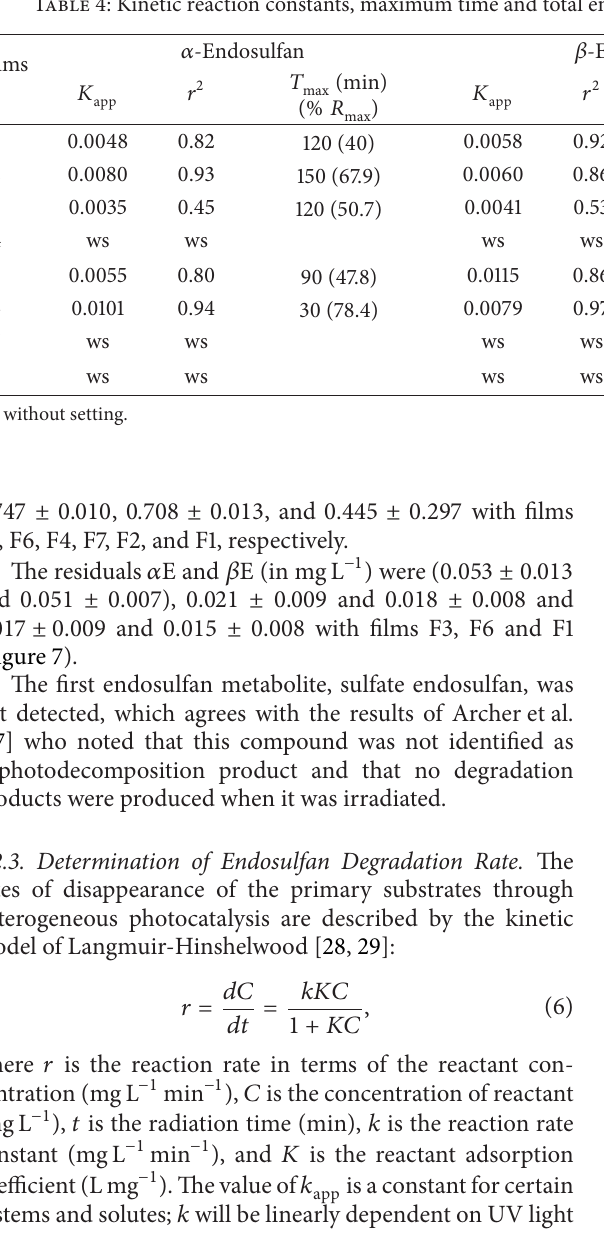
Figure 5: Initial endosulfan concentration in photoactivity assays employing 2 3 factorial experimental design. Table 4: Kinetic reaction constants, maximum time and total endosulfan degradation during photoactivity assays (TiO